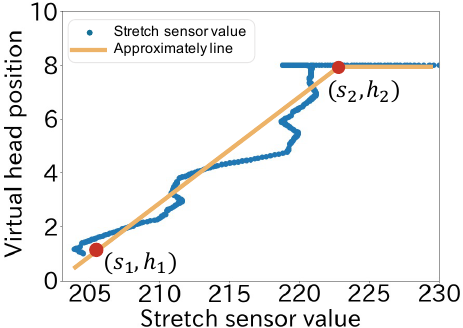
Figure 8. Mapping method in the upward direction.